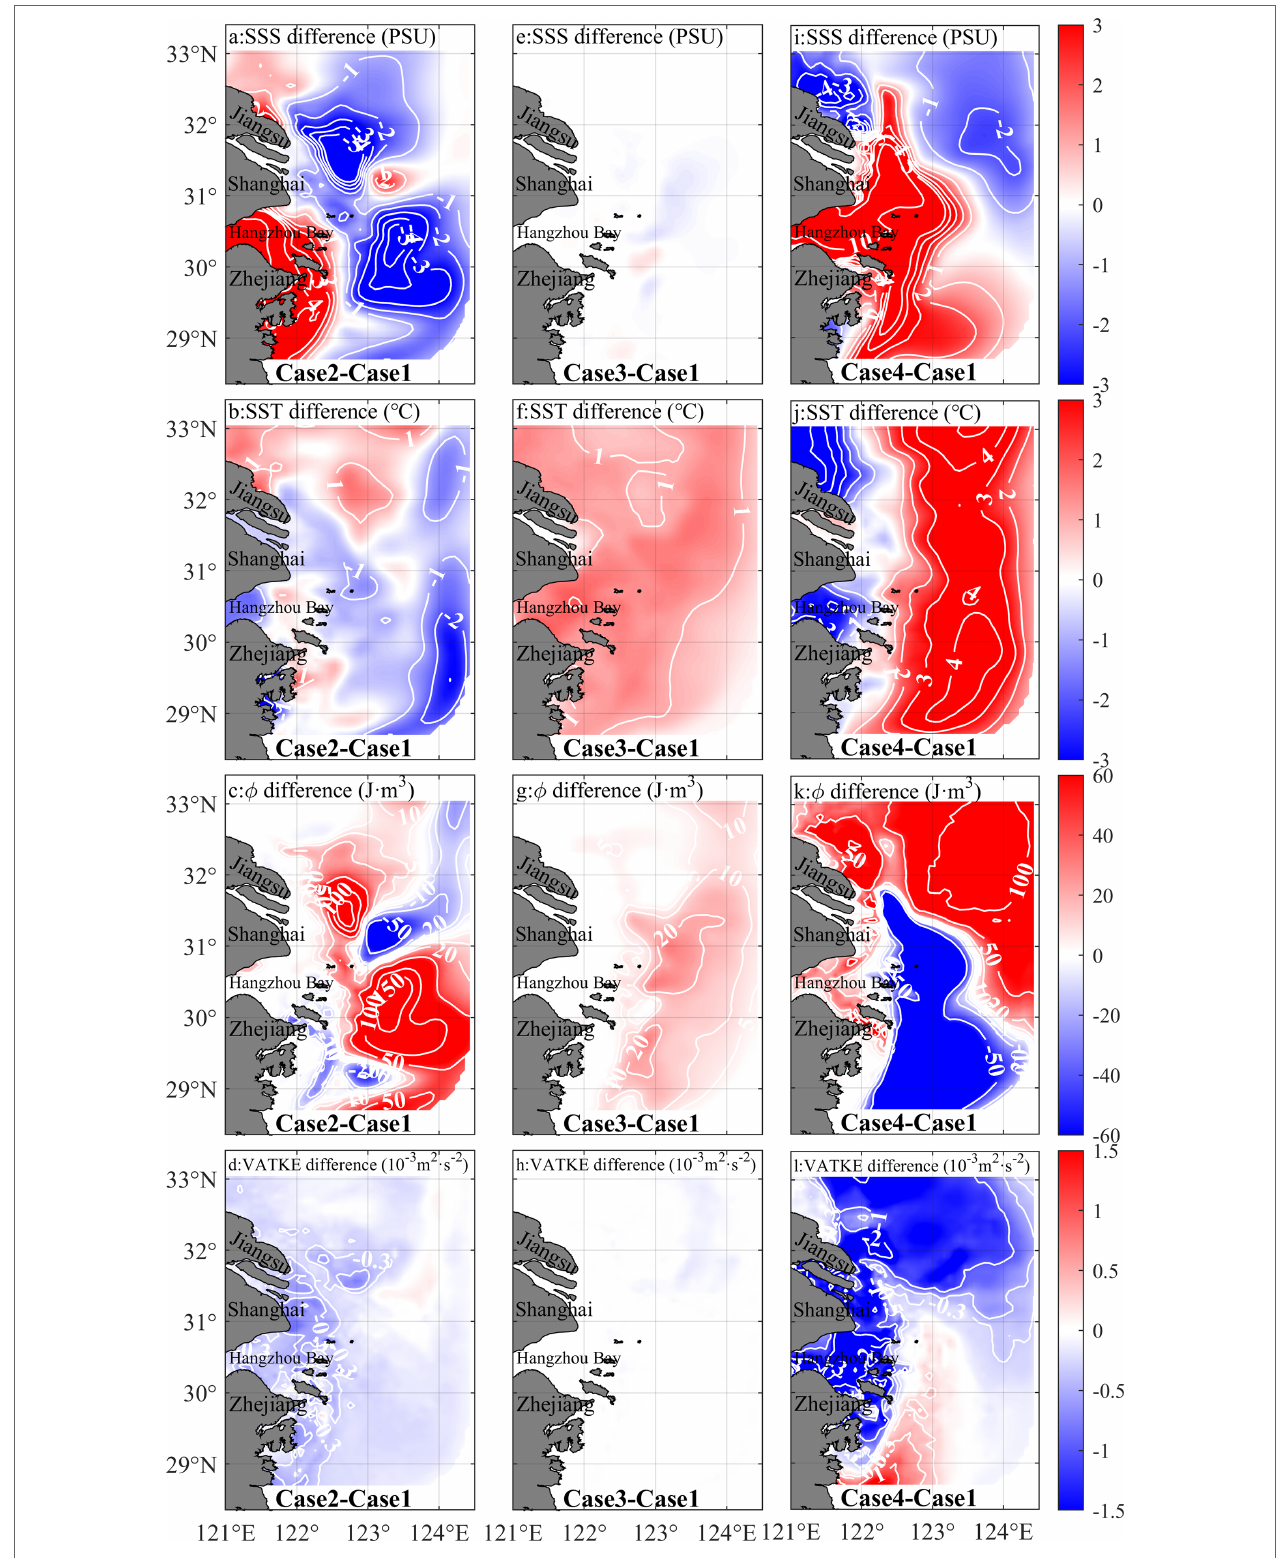
FIGURE 8 | Spatial patterns of temporally averaged difference of SSS, SST, Ø, and VATKE between Case2 and Case1 (A–D) , Case3 and Case1 (E–H) , and Case4 and Case1 (I–L) during the formation period of July 3–19,